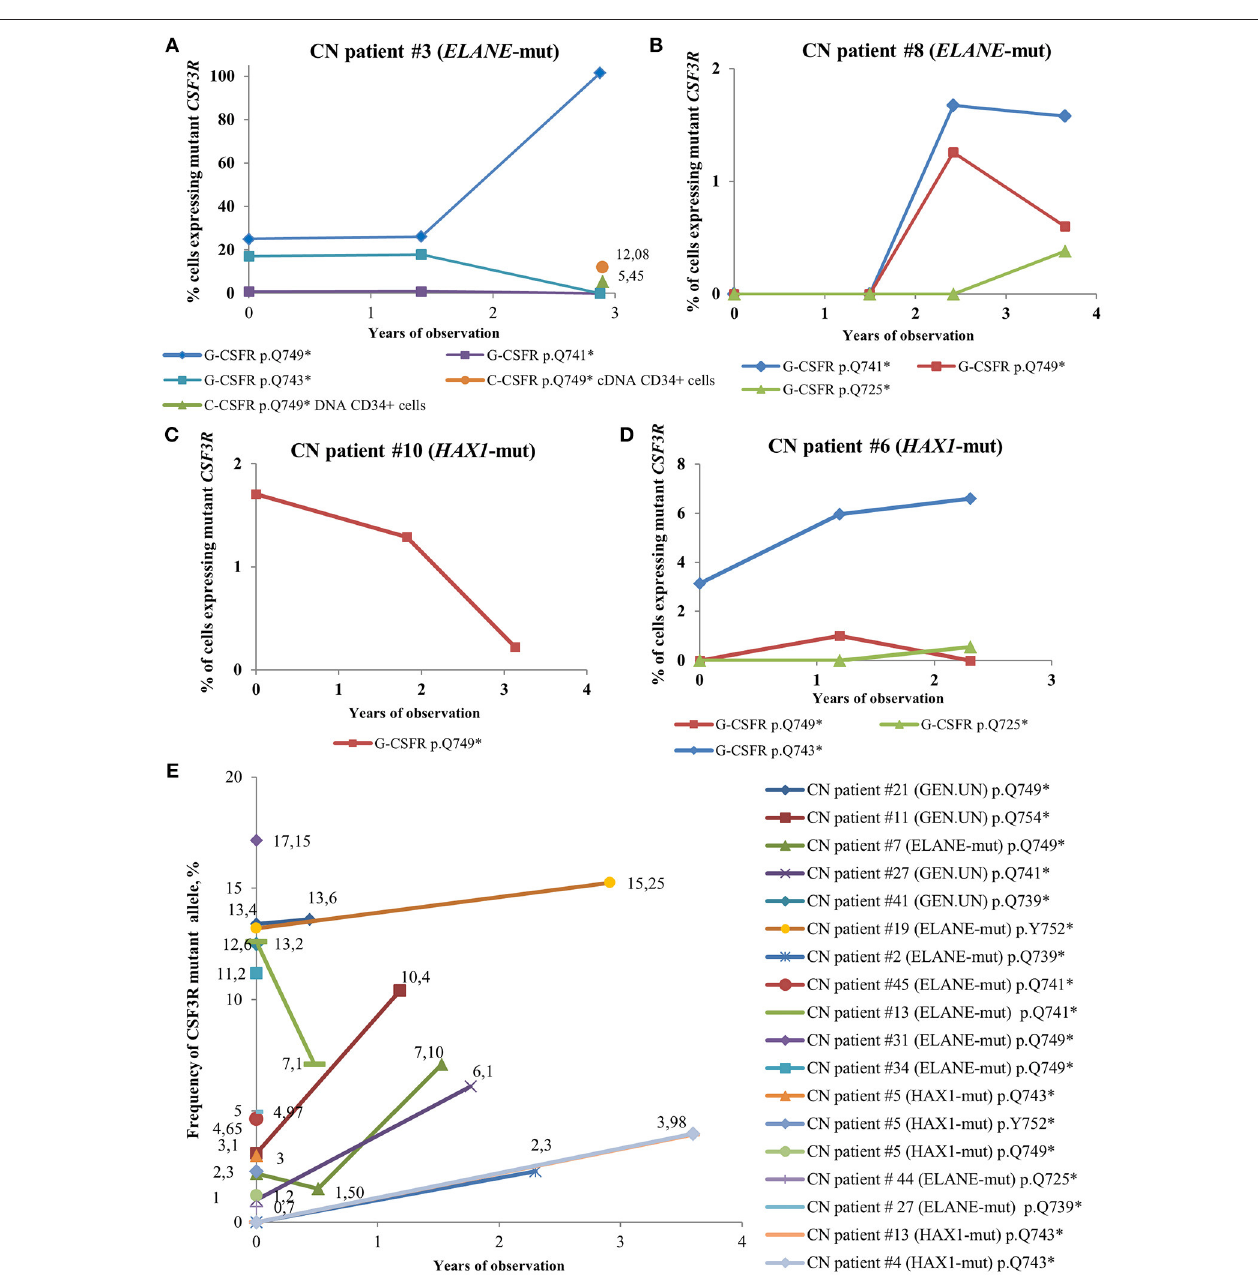
FIGURE 4 | Time-course of CSF3R mutations in sequential samples from CN patients detected by cDNA and DNA deep sequencing. (A–D) The percentage of cells expressing mutant CSF3R at different time points (in years), starting from the date of the first CSF3R mutation analysis in a given patient, is plotted. All mutations are considered to be heterozygous. The CSF3R mutant clones are indicated based on the relative amino acid positions of mutation sites. The number of cells with CSF3R mutation is estimated to be twice the number of reads supporting a mutant allele, *- stop codon. (E) Time-course of CSF3R mutations occurrence and frequency of mutant alleles in DNA samples from CN patients detected by CSF3R DNA deep sequencing. The frequency of mutant alleles at different time points (in years) in a given patient is plotted. The number of cells with CSF3R mutation is estimated to be twice the number of reads supporting a mutant allele, *- stop codon.